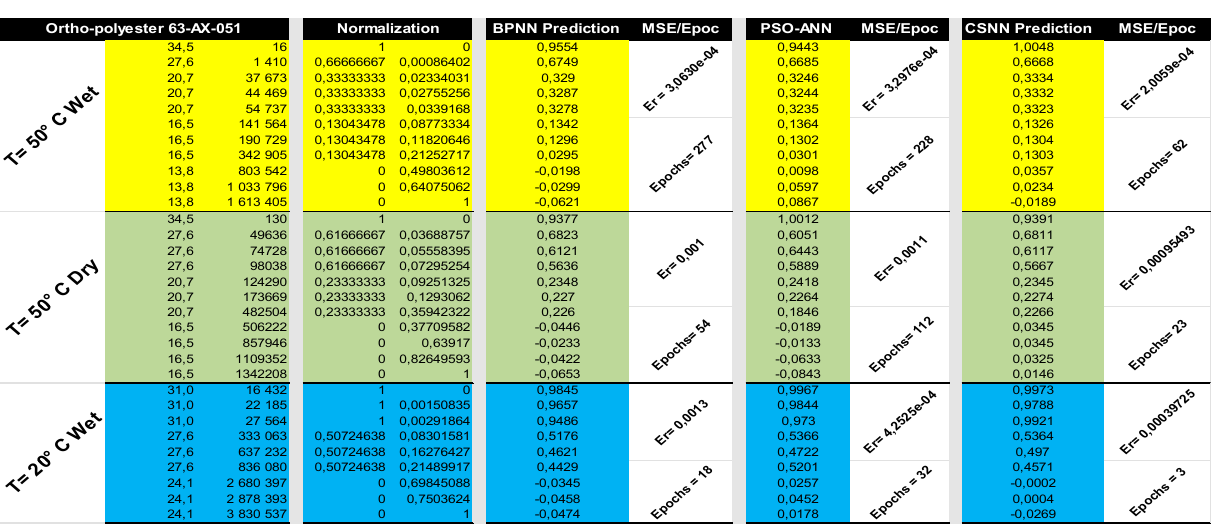
Figure 4. Excel file summary for the preparation of ortho-polyester data.